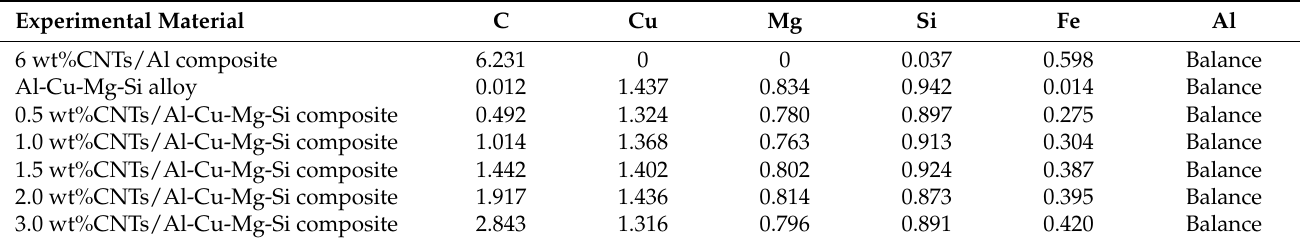
Table 1. Chemical compositions of the experimental materials